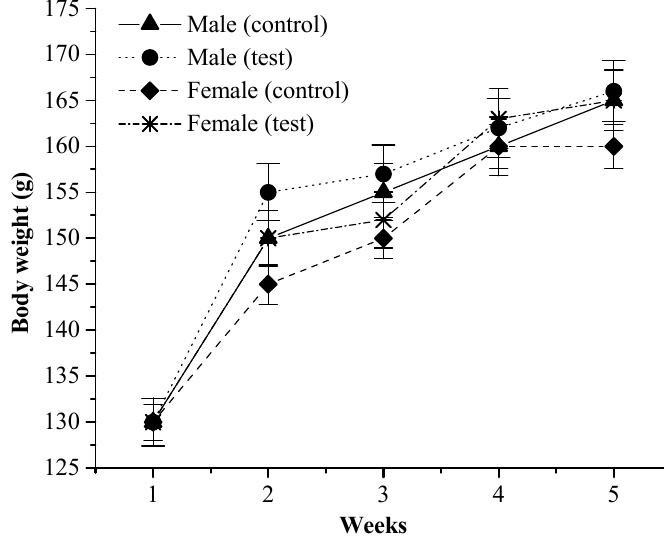
Figure 1. Mean body weight of rats administered with tomato powder suspension (TPS) for 4 weeks. Each point represents mean of six determinations. Error ranges denote one standard deviation from the mean ( n = 6).